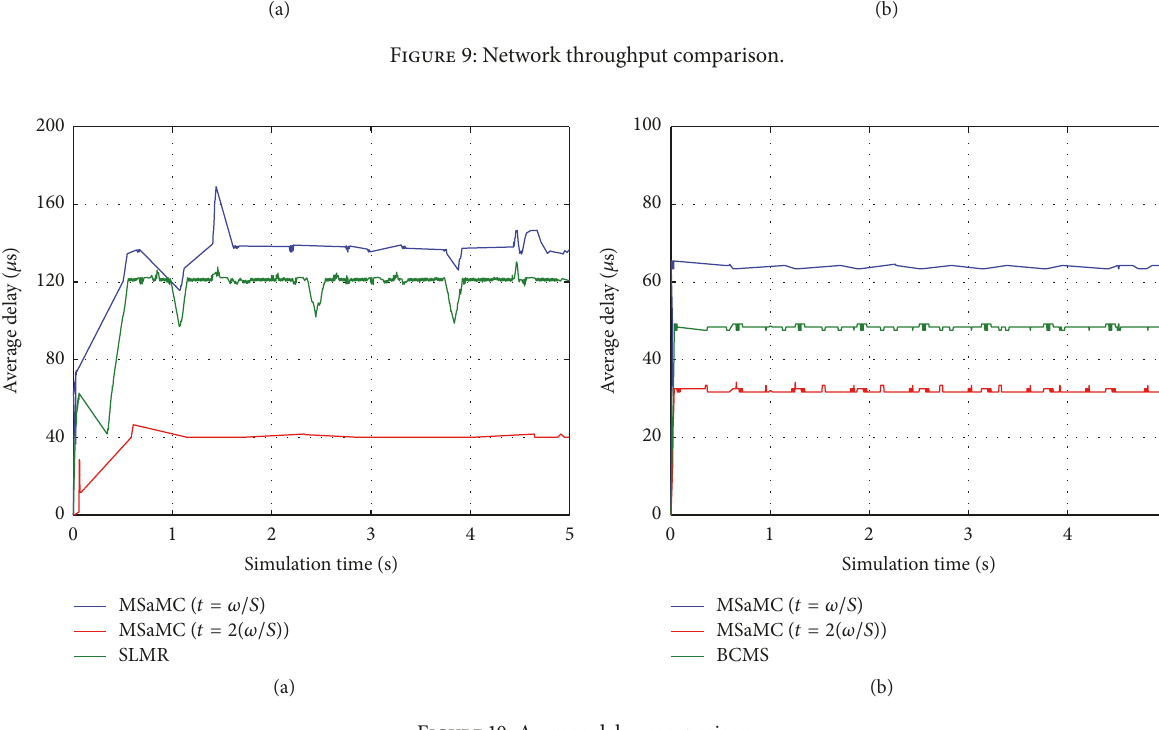
Figure 10: Average delay